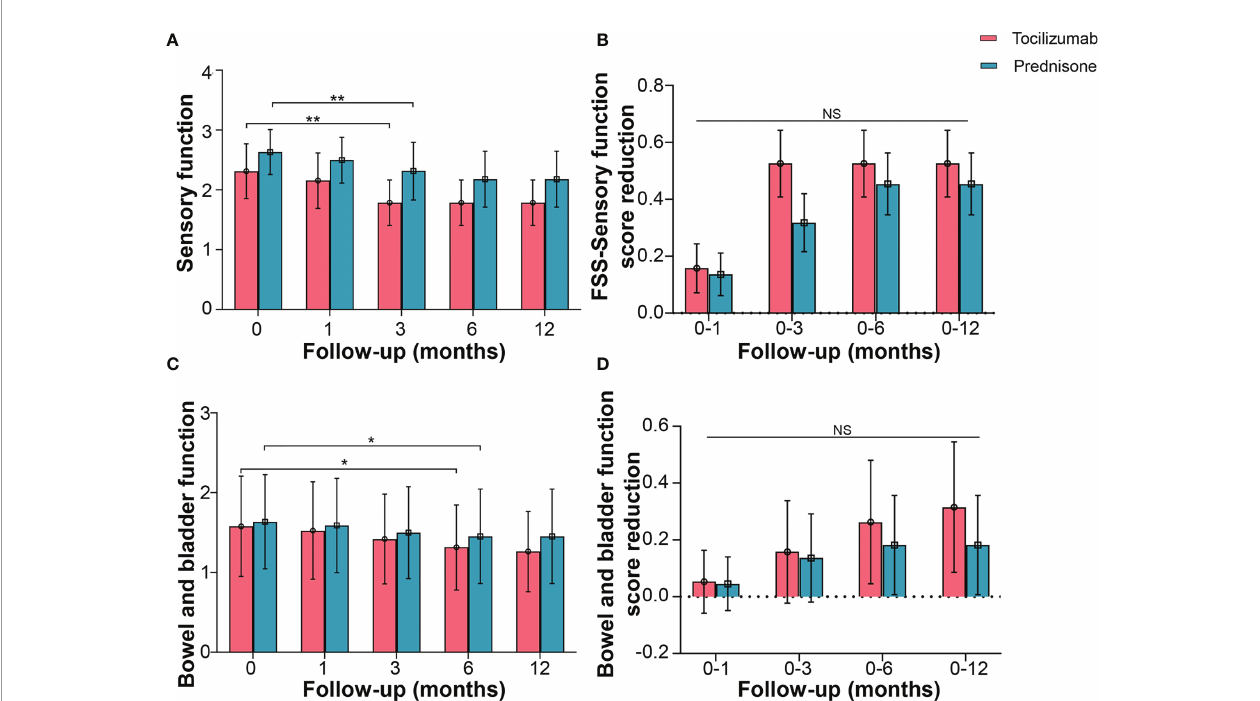
FIGURE 5 | Effects of tocilizumab and prednisone on sensory function and autonomic (bowel and bladder) function. (A) Changes of FSS sensory function score at baseline, 1 month, 3 months, 6 months, and 12 months in patients receiving tocilizumab and prednisone. (B) Comparisons of FSS sensory function score reduction rate between the two groups. (C) Changes of FSS bowel and bladder function score in patients with neuromyelitis optica spectrum disorder (NMOSD). (D) Comparisons of FSS bowel and bladder function score reduction between the two groups. * p < 0.05; ** p < 0.01; NS, not signi fi